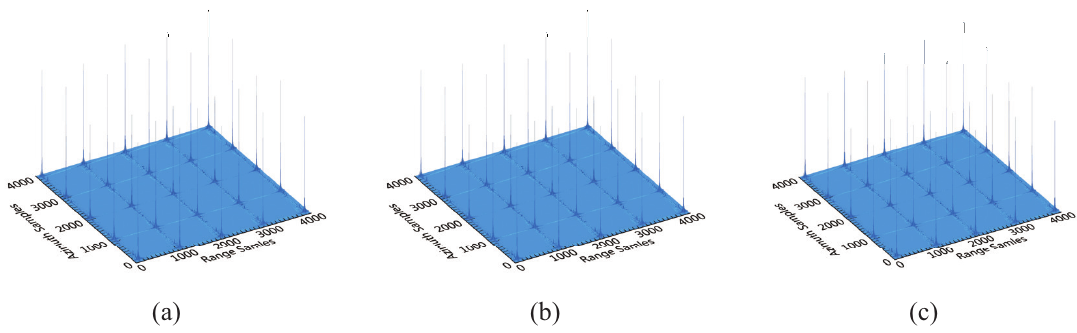
Figure 8. Point array simulation results: ( a ) processed by FFBP; ( b ) processed by Block_FFBP; ( c ) processed by MoBulk_FFBP. A 4 km × 4 km scene containing a 5 × 5 point array is shown. Table 1. Simulation parameters of the monostatic SAR case. PRF, pulse repetition frequency. Parameter Values